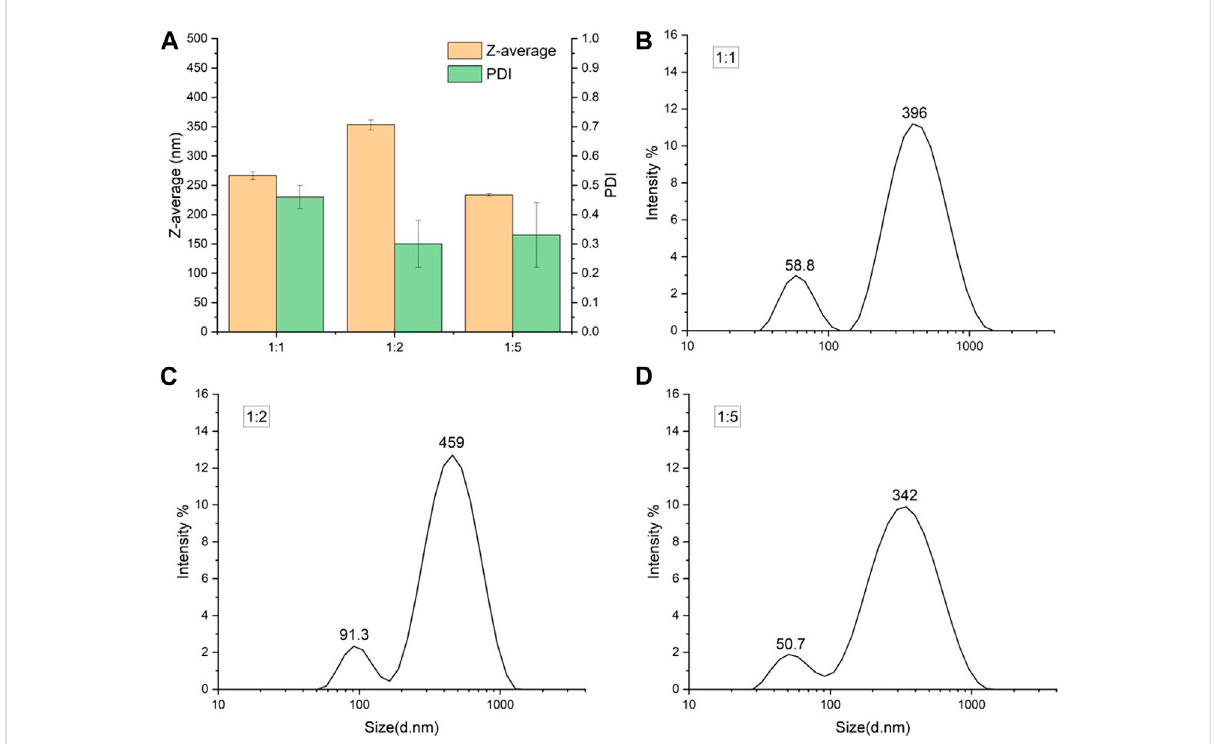
FIGURE 3 Particle size of freeze-dried SNPs prepared by different starch solution to ethanol volume ratios. (A) Z-average and PDI for three ratios. Size distribution of SNPs prepared at starch solution to ethanol volume ratio 1:1 (B) , 1:2 (C) and 1:5 (D) .